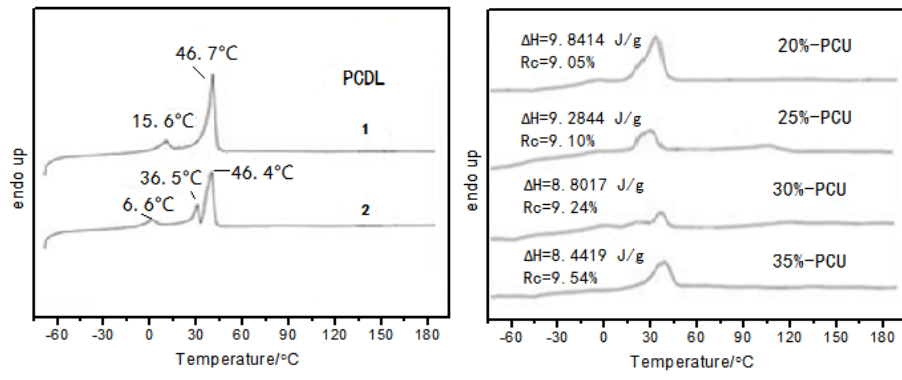
Figure 5. The DSC of the raw material PCDL and the prepared polymer.